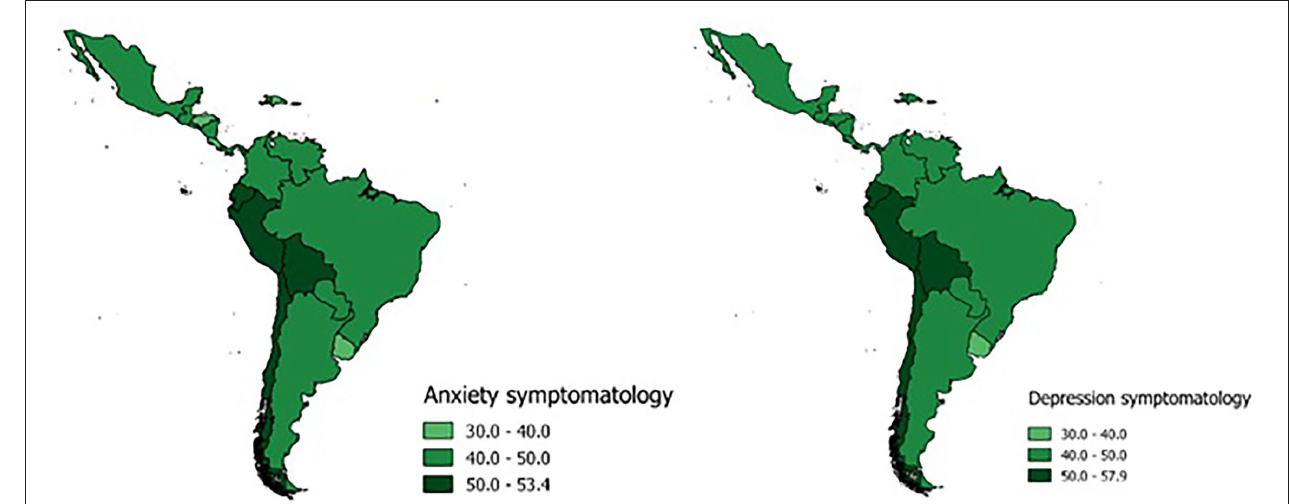
FIGURE 1 | Anxiety and depression prevalences according to the Latin American and the Caribbean